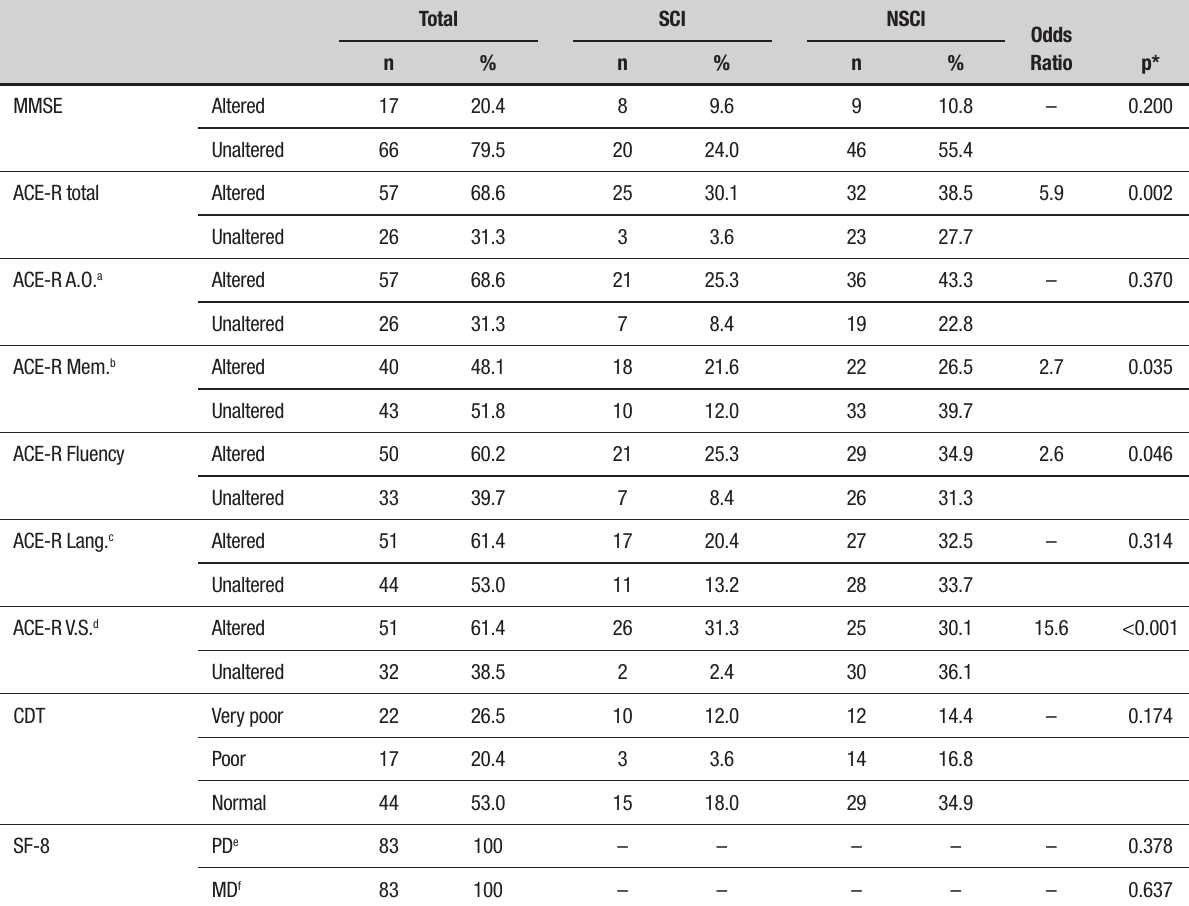
Table 3. Results of associations between instruments used and MCS-B, by